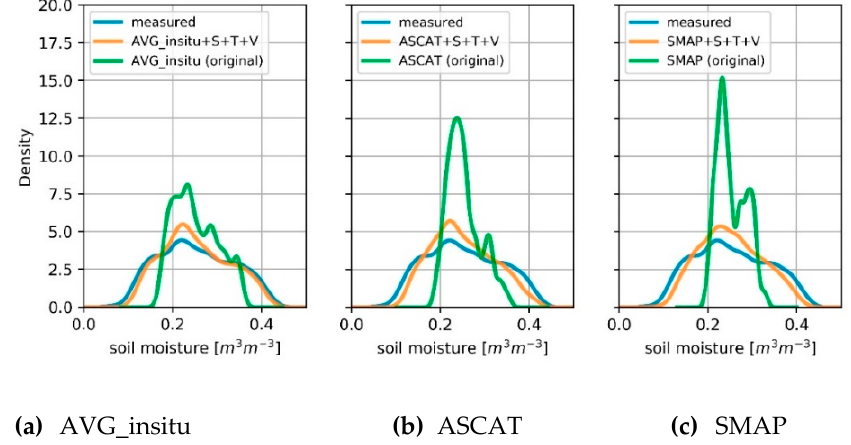
Figure 7. Density distributions of soil moisture obtained for in-situ measurements (blue lines), downscaled soil moisture from the model combination SSM + S + T + V (orange lines), and the original coarse-scale SSM products (green lines). ( a ) AVG_insitu, ( b ) ASCAT, ( c ) SMAP.